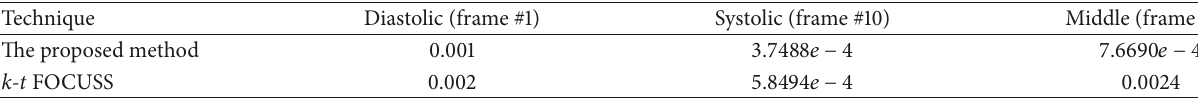
Table 3: MSE comparison for the proposed method and k-t FOCUSS with MEMC.